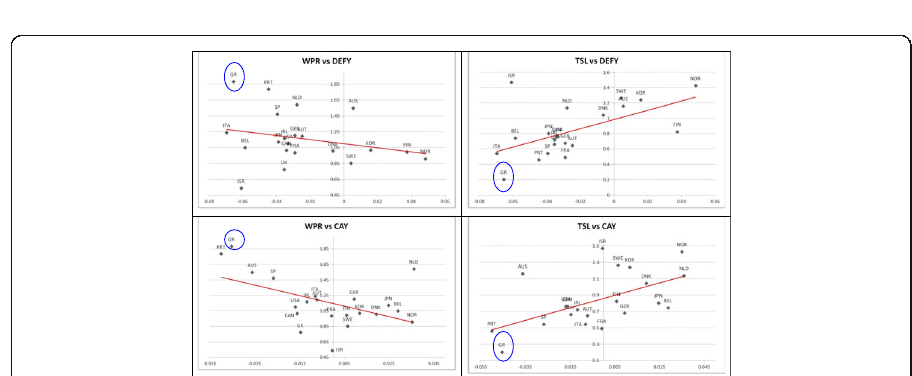
Fig. 10 Twin deficits. Note : (i) Median values (maximum time span 1970 – 2010) and (ii) the red line is the linear regression line